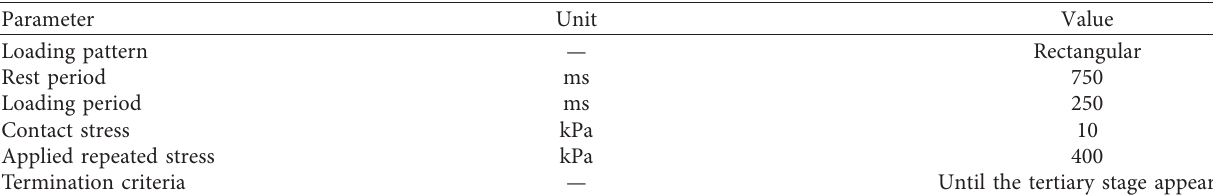
Figure 4: Dynamic creep test: (a) dynamic creep test apparatus and (b) permanent strain curve. Table 7: Variables of the dynamic creep